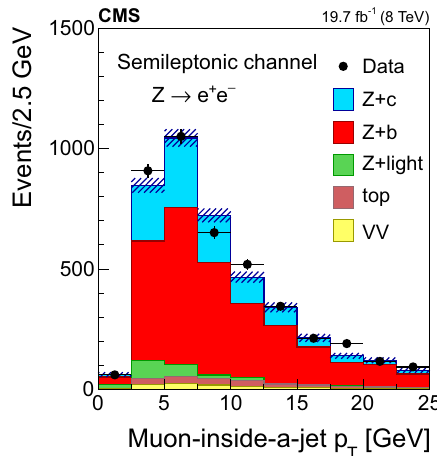
all processes are estimated with the simulated samples. Vertical bars on data points represent the statistical uncertainty in the data. The hatched areas represent the statistical uncertainty in the MC simulation